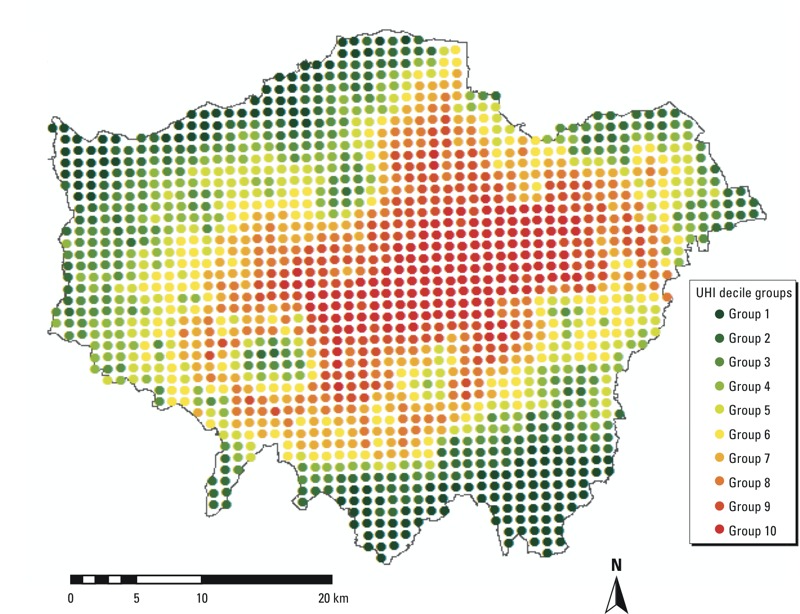
London urban heat island (UHI) anomaly decile groups. UHI anomalies were defined by the annual mean of daily excess temperature at each grid square relative to the average temperature on the same day in London as a whole. Decile group 1 represents the lowest UHI anomaly group (coolest), and decile group 10 represents the highest UHI anomaly group (hottest).